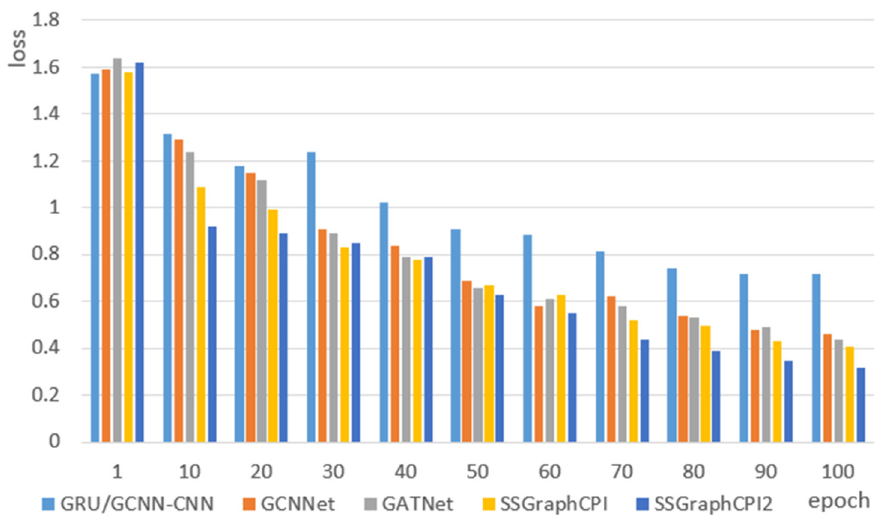
Figure 1. Loss value variation diagram of different models.